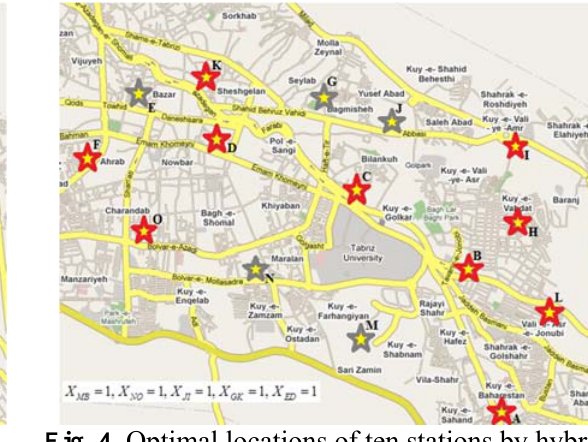
Fig. 3. Optimal locations of ten stations by possibility and necessity-based models